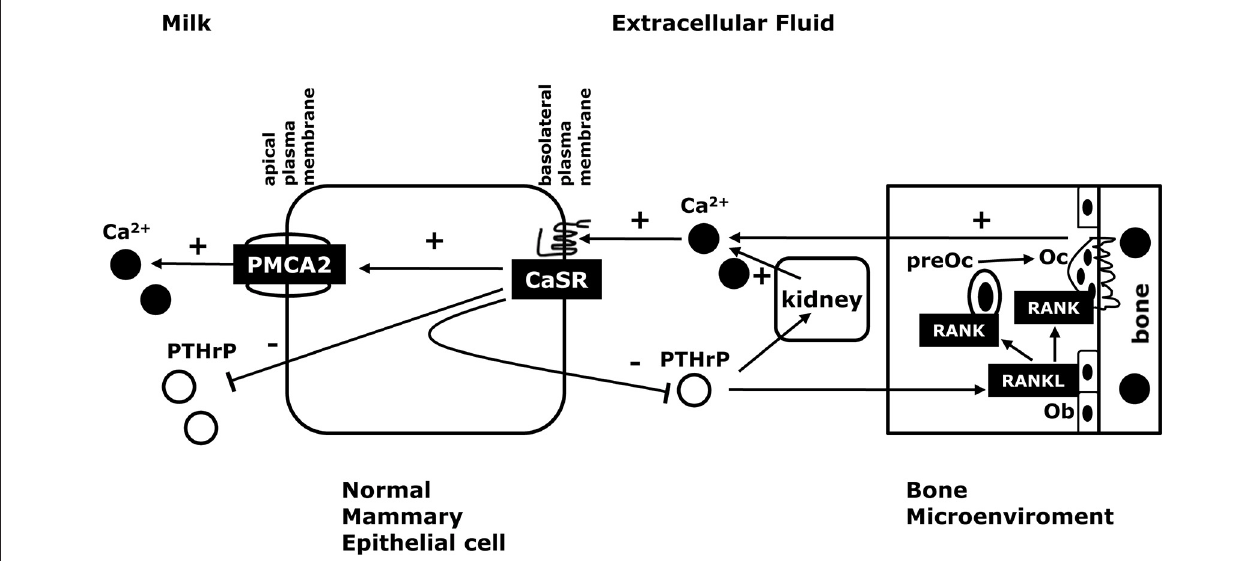
FIGURE 1 | The CaSR in normal lactation. Activation of the CaSR in the lactating breast promotes trans-epithelial calcium transport into milk by increasing the activity of the calcium pump, PMCA2. In addition, activation of the CaSR suppresses PTHrP release into milk and into the systemic circulation. Circulating PTHrP acts on osteoblasts (Ob) to increase osteoclast (Oc) development and activity through the RANK/RANKL pathway. This, in turn, stimulates bone resorption and liberates skeletal calcium stores. PTHrP also acts on the kidney to stimulate calcium reabsorption. If serum calcium is decreased, the CaSR decreases calcium transport into milk to decrease calcium utilization and increases PTHrP secretion into the maternal circulation to increase the supply of calcium from skeletal stores. In this way, the CaSR helps to maintain a steady supply of calcium for milk production and protects the mother from hypocalcemia if dietary calcium become